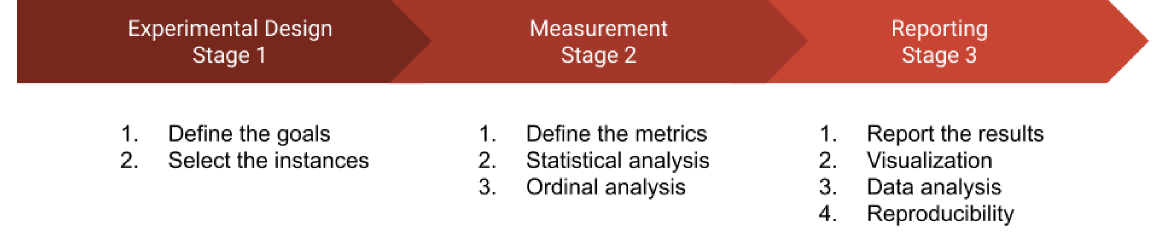
Figure 2. Evaluation stages to determine the performance of an